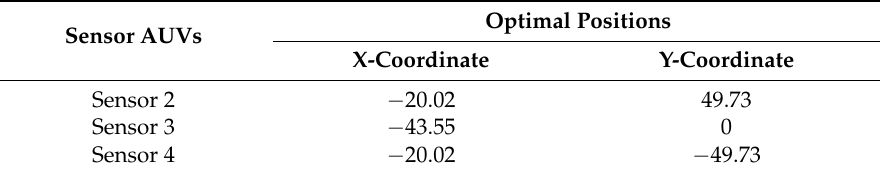
Table 1. Optimal Positions of Sensor AUVs (Single Target: CSP).